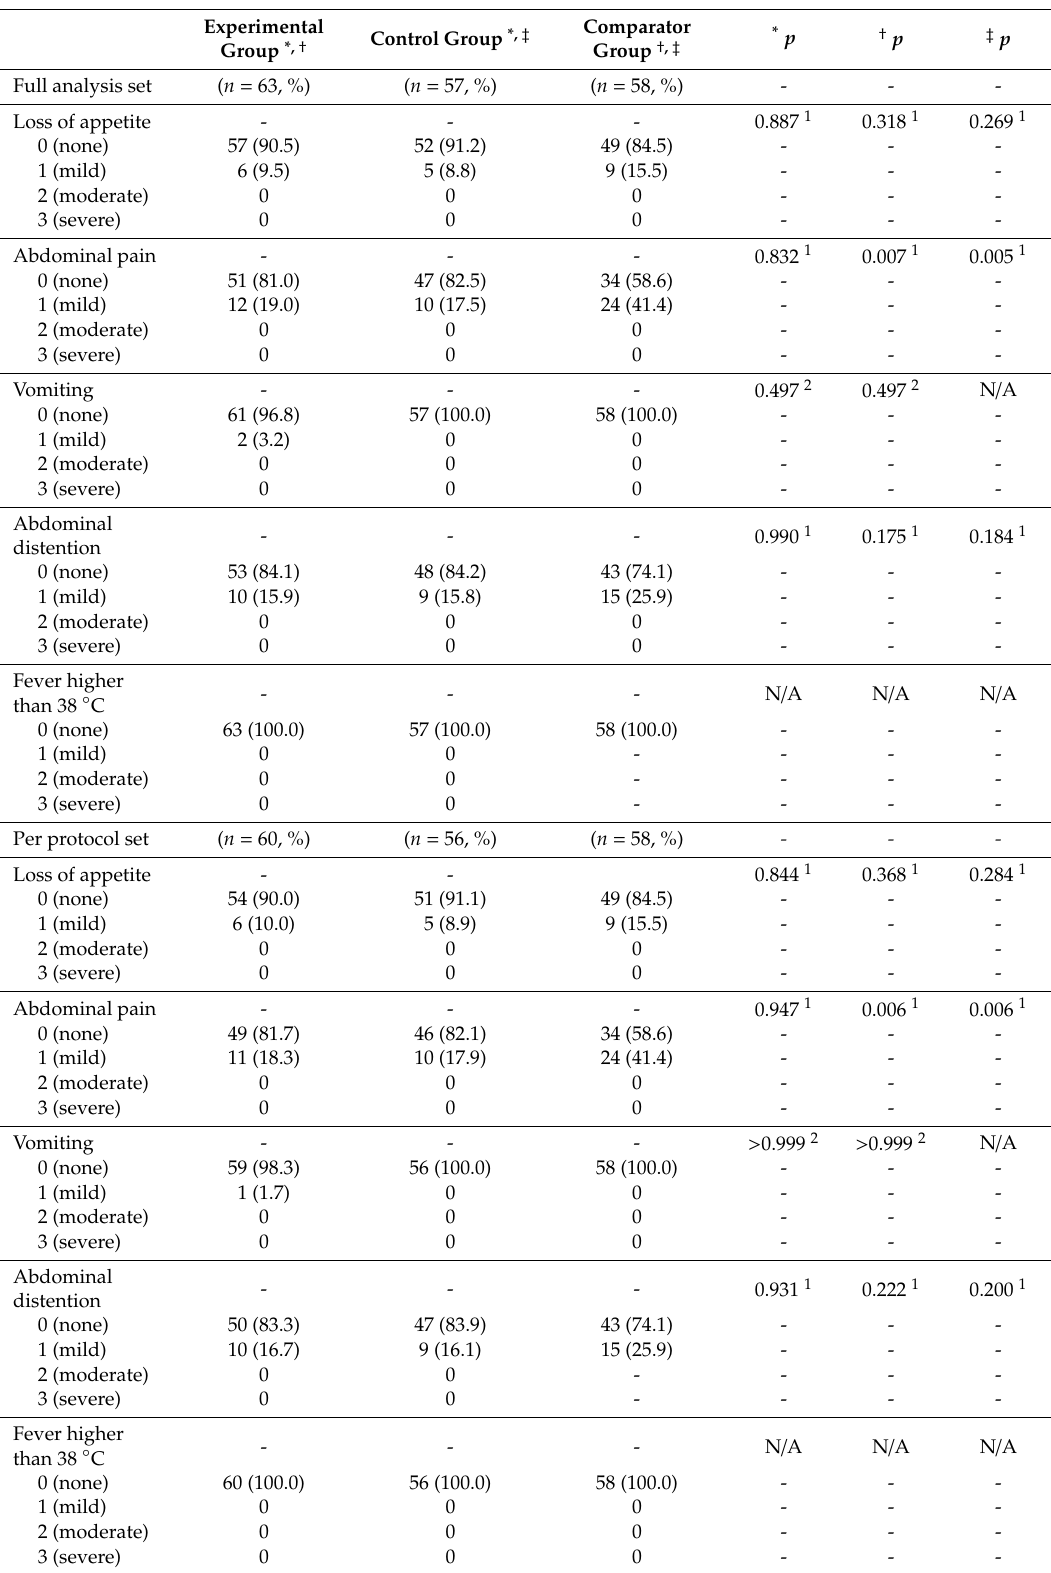
Table 3. Incidence rate of adhesion symptoms at 4 weeks after